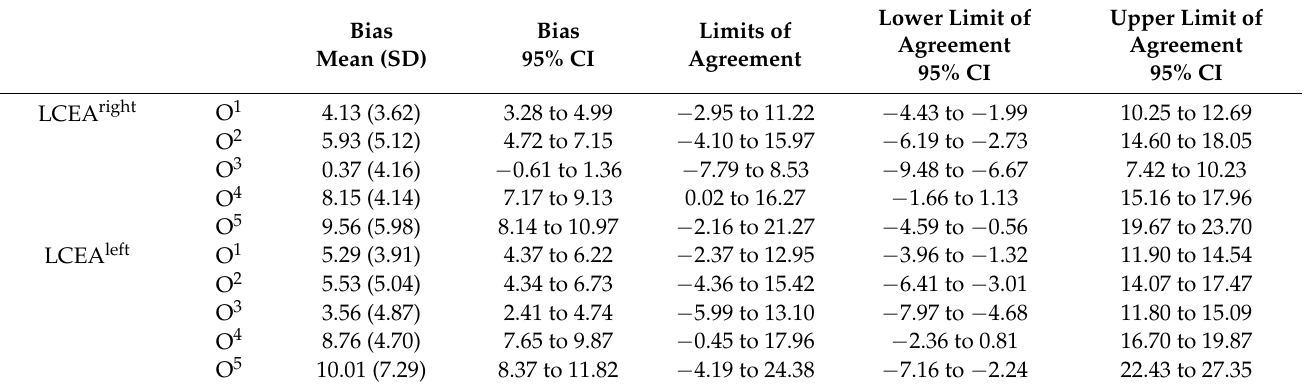
Figure 4. Scatter plots with human measurements of LCEA and AIA over algorithm measurements. LCEA; Lateral center edge angle, AIA; Acetabular index angle. Scatter plots in the top row line (LCEA) depict a tendency that human readers measure the LCEA at a higher value than the algorithm, although the senior orthopedic surgeon agree the most with the algorithm (green dots seen in close proximity to the red identity line). Table 3. Lateral center edge angle. Bland Altman limits of agreement and bias (mean and SD). Agreement between algorithm and individual human readers. (n =